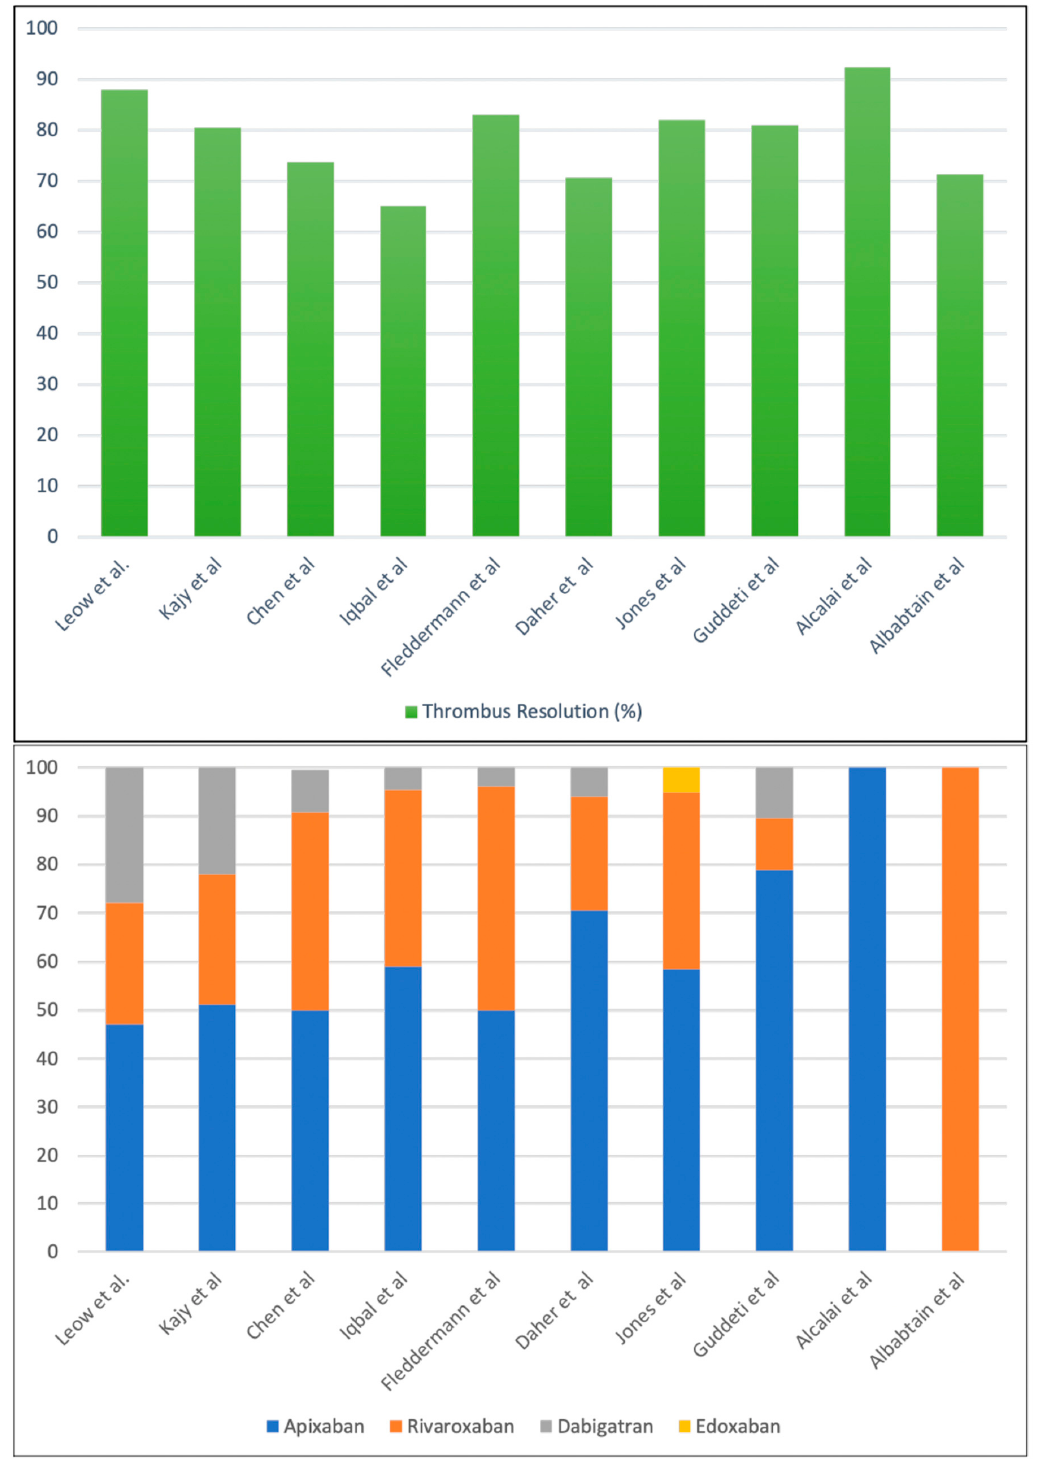
Figure 3. Rates of thrombus resolution observed in various studies/meta-analyses of studies utilizing DOACs for anticoagulation for LV thrombi (upper panel) and the proportion of various DOACs used in these studies (lower panel). Factor Xa inhibitor—apixaban has been the most extensively utilized DOAC, and edoxaban was the least favored. The first three columns represent meta-analyses, while the other seven represent individual studies.